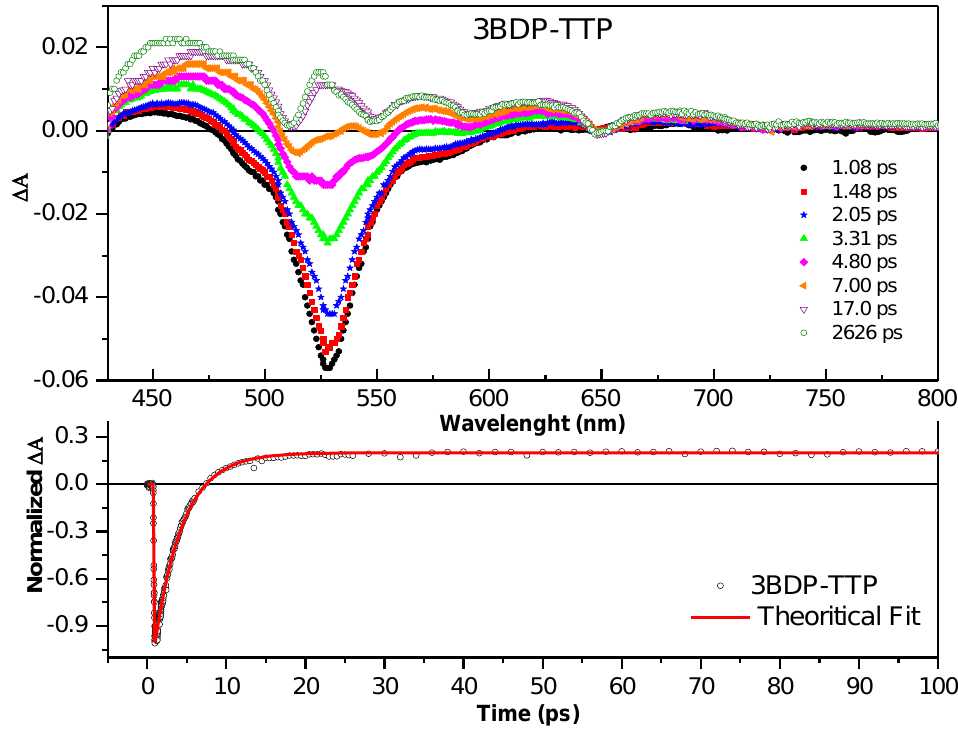
Figure 6. ( top ) The transient absorption spectra of 3BDP-TTP with different time delays. ( bottom ) Decay traces of 3BDP-TTP at the 524 nm probe wavelength.